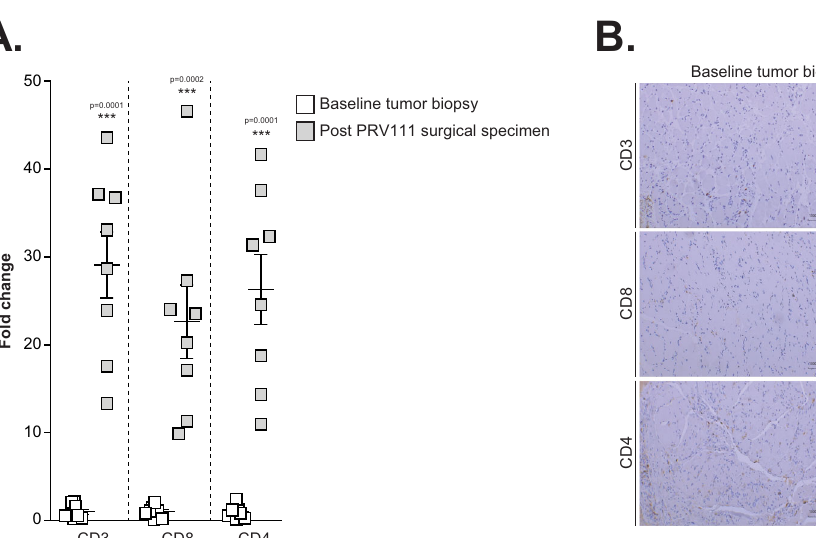
Fig. 6 PRV111 increased the number of TILs. A Fold change increase in TILs after treatment of 8 patients with PRV111 relative to pretreatment biopsies, shown as average ± SEM ( p < 0.001; Student ’ s unpaired t -test). Four slides were analyzed for each specimen and average was used for fold change calculation. B Representative images (10×; scale bar — 1000 μ m) of pre- and post-treatment sections stained for CD3, CD8, and CD4 T cells. Changes in brown staining indicates increase in tumor-in fi ltrating lymphocytes following PRV111 treatment. Source data are provided as a Source Data fi